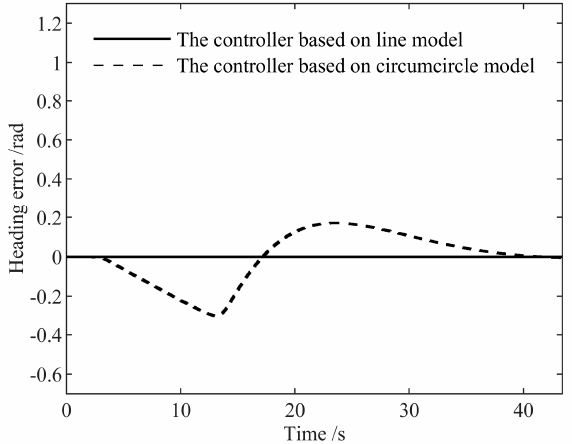
Figure 13. Displacement error between P and the reference path in the first group of simulations.